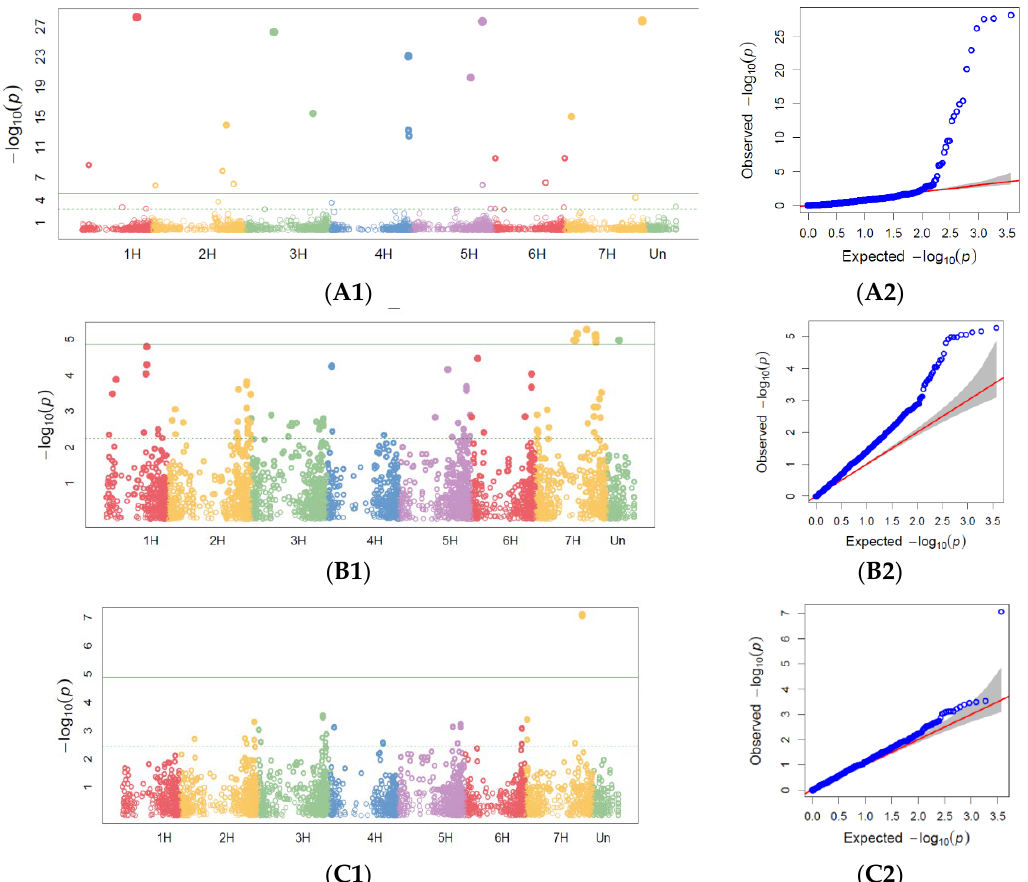
Figure 14. Single-nucleotide polymorphism (SNP) significantly associated with stem rust (SR) resistance in barley identified by genome-wide association study (GWAS) with BLINK model. Manhattan plot and quantile–quantile plot for 2019 heading stage Figures ( A1 ) and ( A2 ); Man-